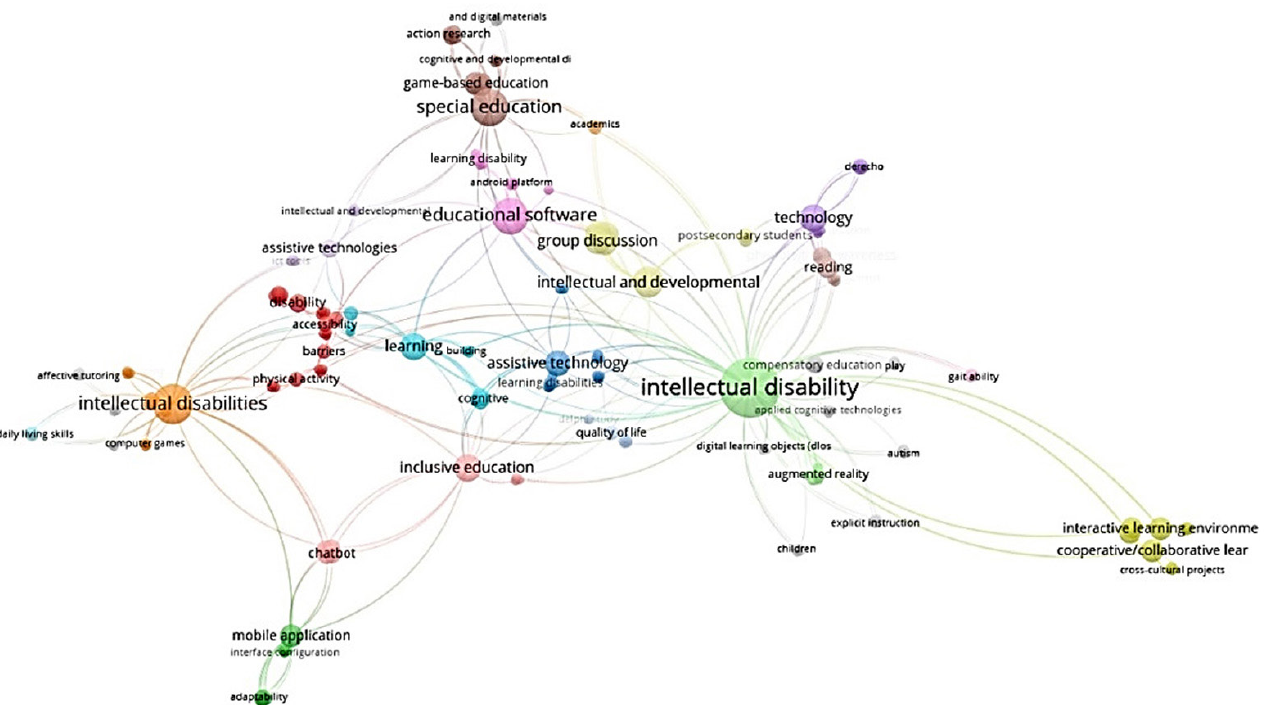
Fig. 7. Bibliometric visualization map of the most frequent common